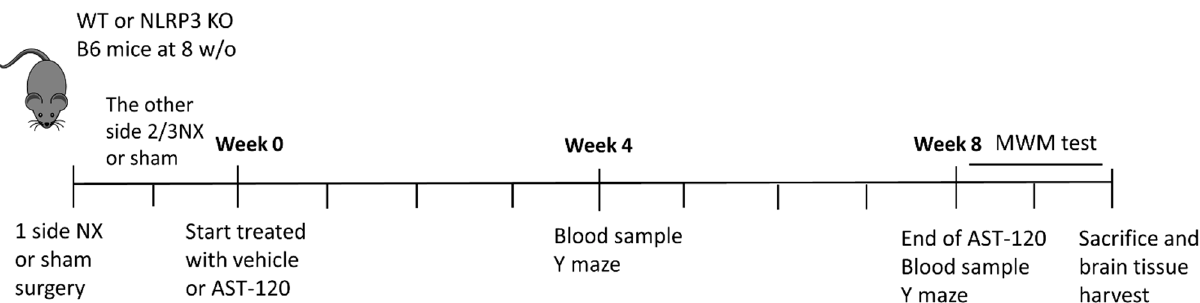
Figure 1. The flowchart indicating each time-point of experiment and behavioral test. Eight-week-old male C57BL/6J mice (or NLRP3 knockout mice) received sham surgery or 2-step 5/6 nephrectomy (NX) 2 weeks before AST-120 treatment. At week 0, mice were divided and treated with or without 10% AST-120. Blood was drawn from the tail vein at week 4 and week 8. Y maze tests were performed on week 4 and week 8. Morris water maze (MWM) tests were performed start from week 8. Mice were sacrificed at around week 10 and brain tissues were harvested for uremic toxin quantification, Western blotting and staining. NX: nephrectomy; WT: wild type; each interval of chart is a week.